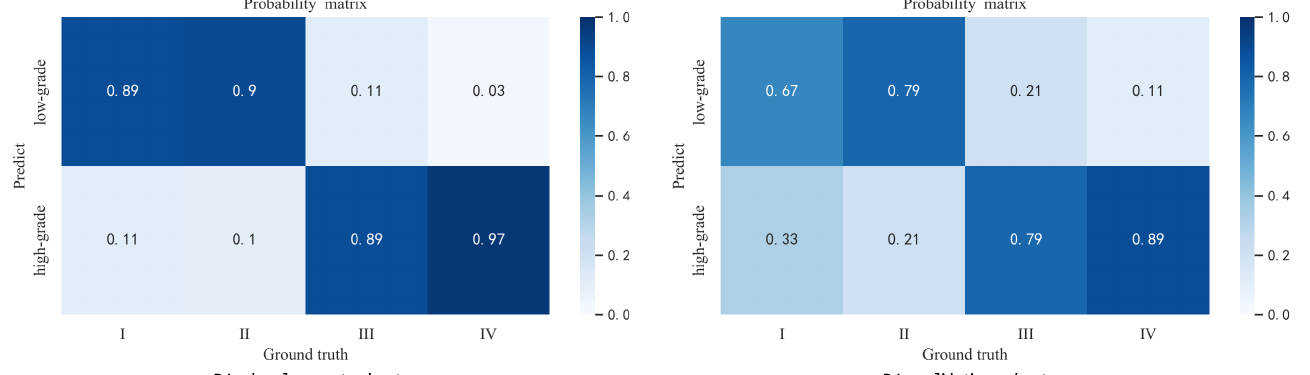
Figure 4. Network output probabilities for low-grade and high-grade patients. The left subplot is the network output probability distribution of low-grade and high-grade patients. The right subplot is the CT images of low-grade and high-grade patients with different network output probabilities.